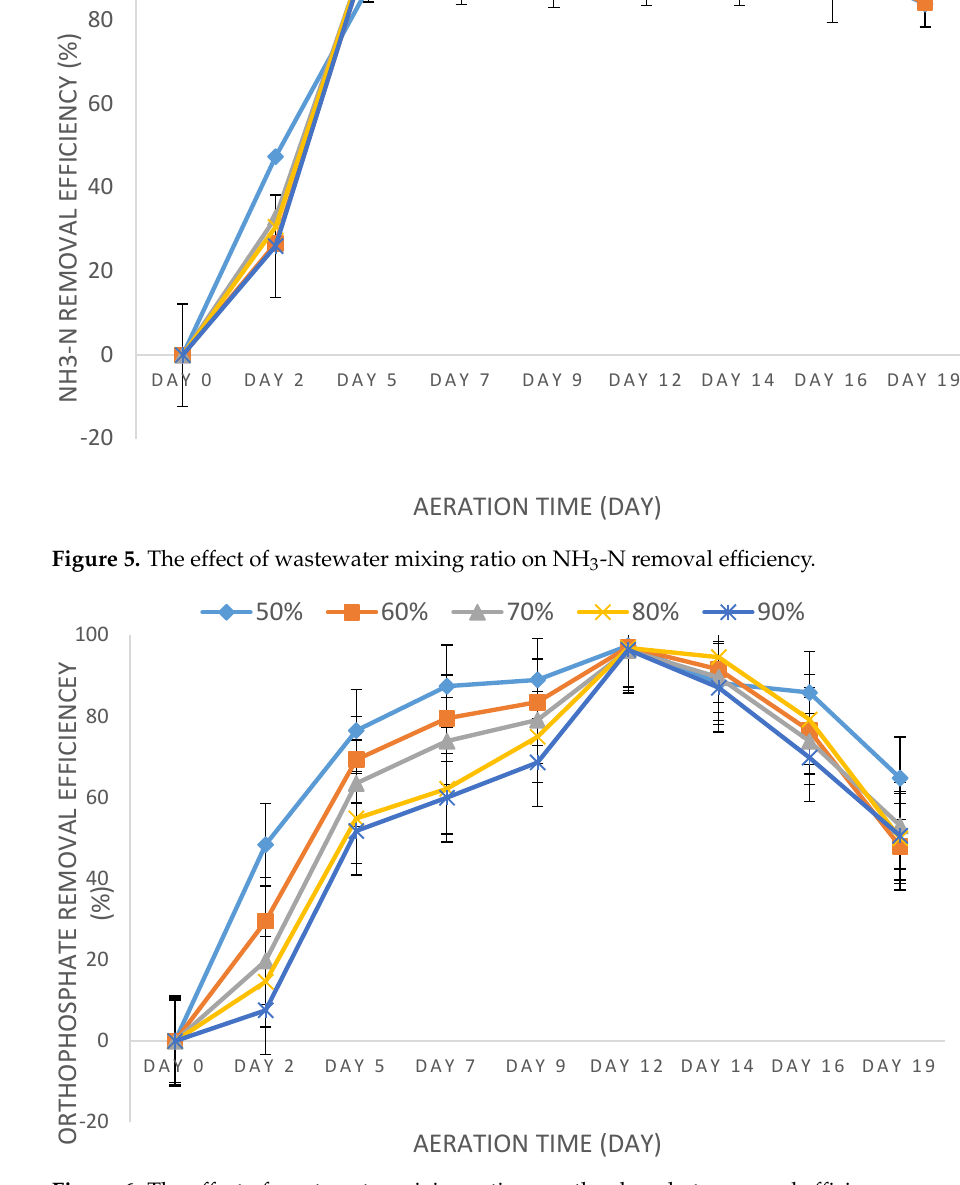
Figure 6. The effect of wastewater mixing ratio on orthophosphate removal e ffi ciency.